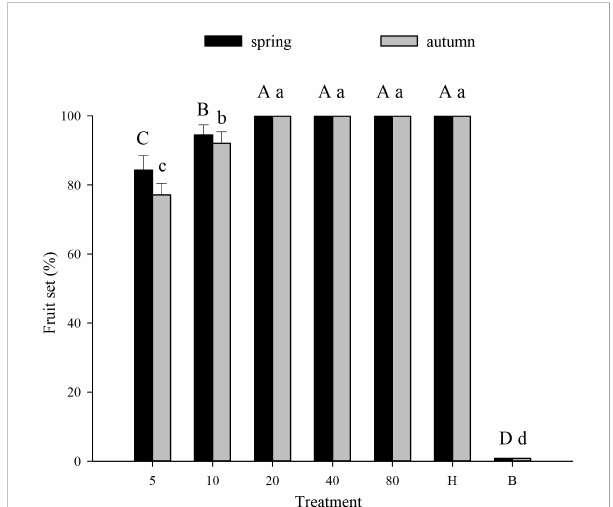
FIGURE 3 Fruit set of muskmelon (% per plant) under different experimental treatments during spring or autumn 2020-21. Numbers in the X axis refer to the total number of hover fl y adults that were released i.e., 5, 10, 20, 40 or 80 pairs; data are also plotted for hormone (H) and bagging (B) treatments. Different uppercase and lowercase letters indicate statistically signi fi cant differences between treatment groups during either season (One-way ANOVA, P <0.05, Tukey ’ s HSD post-hoc